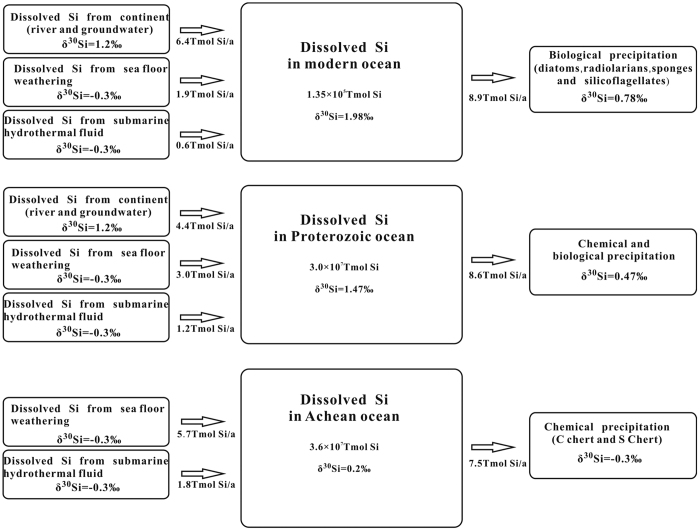
A schematic diagram showing Si cycles in the Archean456, Proterozoic and modern oceans29.